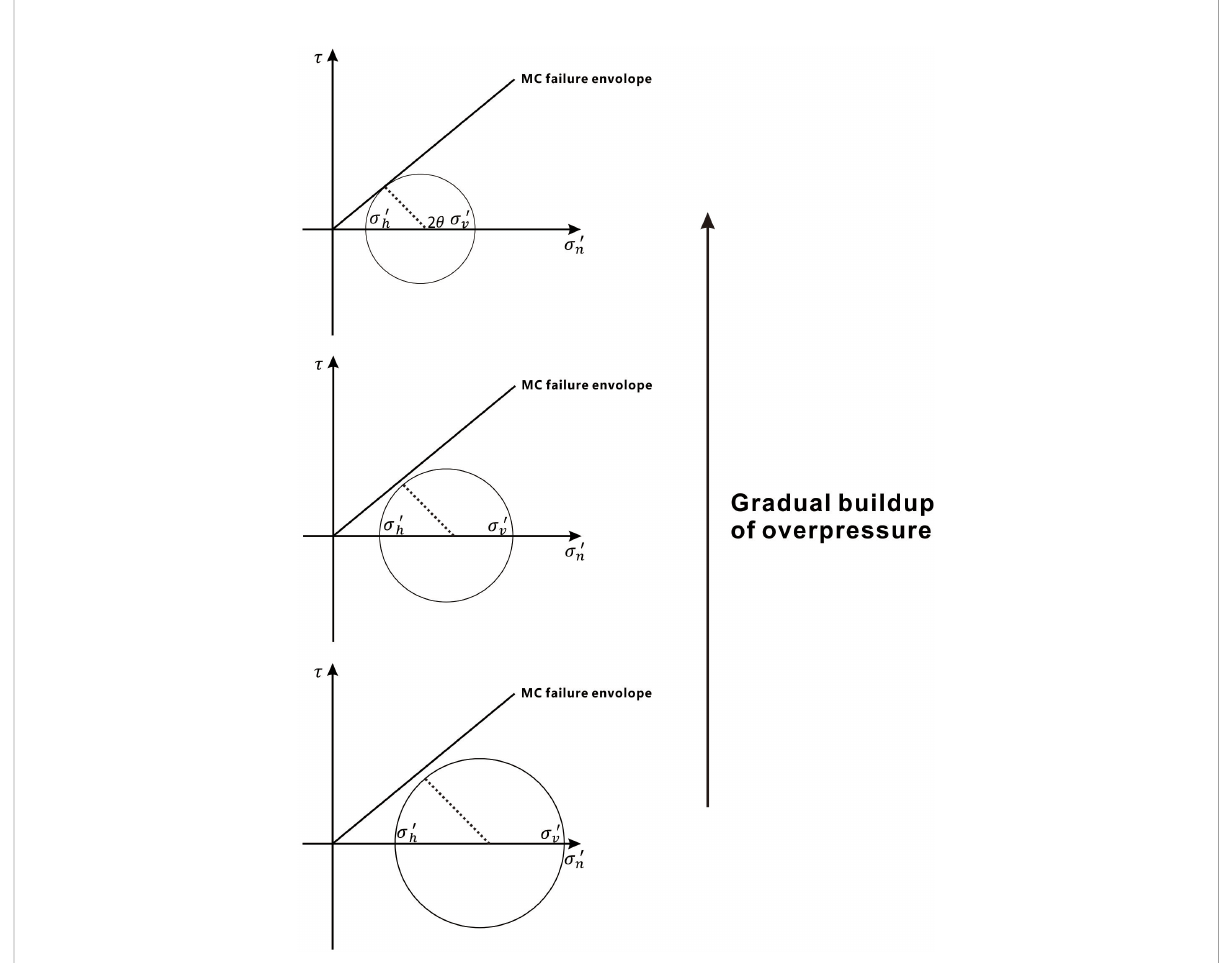
FIGURE 4 Illustration of the occurrence of fault slips, given the fault cohesion is near zero. The process of the gradual buildup of overpressure represent certain scenarios, such as slow gas accumulation beneath hydrate-bearing layers. The increase of overpressure lowers the effective stress and moves the Mohr ’ s circle to the left [modi fi ed from Hornbach et al. (2004)]. s ´ n is the effective normal stress; s ´ v and s ´ h are the effective vertical stress and the effective horizontal stress, respectively; t is the shear stress; q is the fault